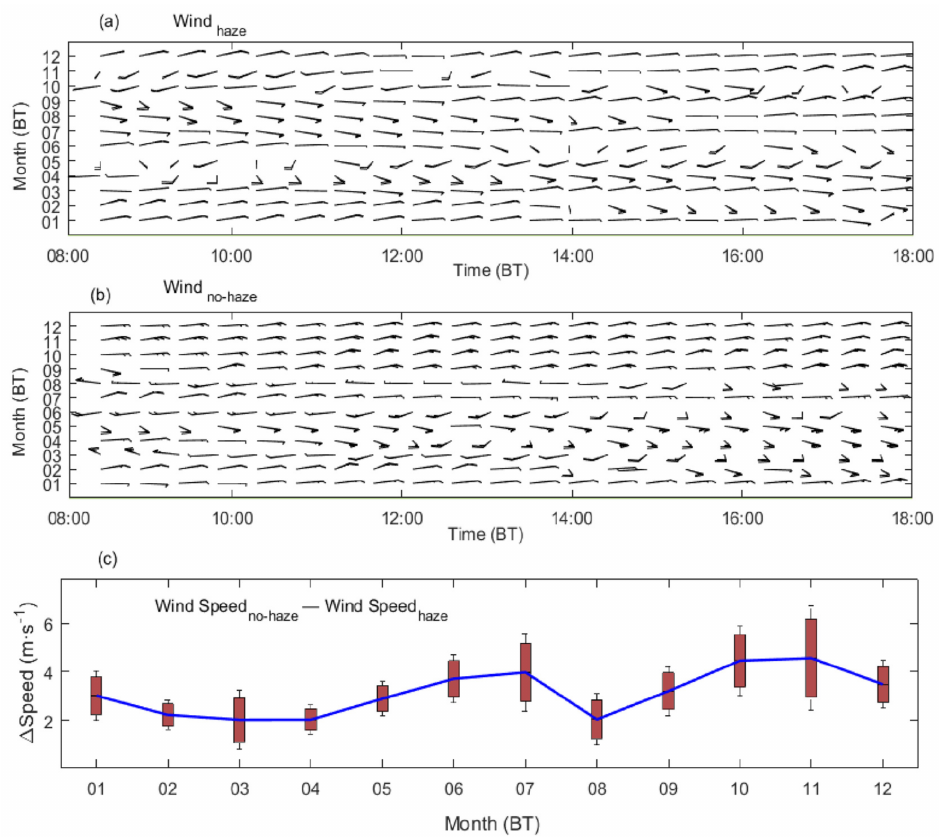
Figure 8. Temporal distribution of average horizontal wind within the BL per half hour during ( a ) the haze events Wind haze and ( b ) the no-haze events Wind no − haze in different months; ( c ) the difference in the Wind Speed no − haze and Wind Speed haze